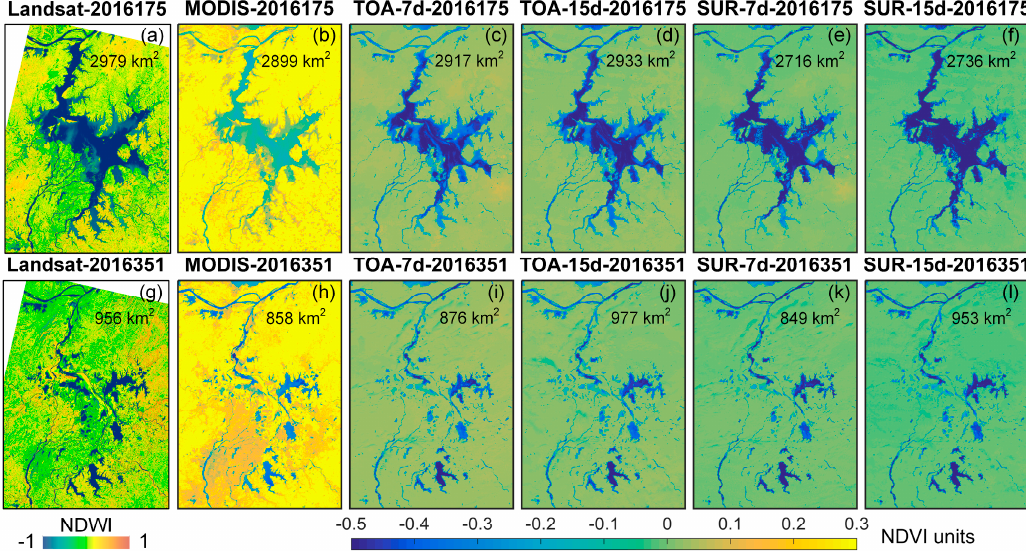
Figure 3. Comparison of MOD13 NDVI ( a , f ), MinVC NDVI based on 7-day top-of-atmosphere (TOA) reflectance data ( b , g ), MinVC NDVI based on 15-day TOA reflectance data ( c , h ), MinVC NDVI based on 7-day surface reflectance data ( d , i ) and MinVC NDVI based on 15-day surface reflectance data ( e , g ). The upper row shows data comparison in the dry season (DOY001, 2003), and the lower row shows data comparison in the wet season (DOY177, 2003).